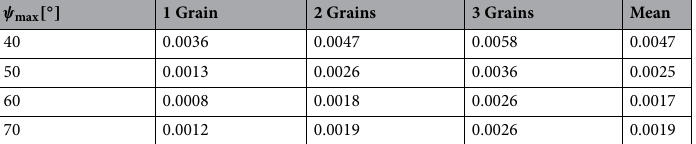
Table 3. MSEs for reconstruction with ψ max from 40 ◦ to 70 ◦ and different numbers of grains. Lower values of MSE indicate better approximation. As to be expected, the error of reconstruction increases with the number of grains and decreases with higher ψ max .